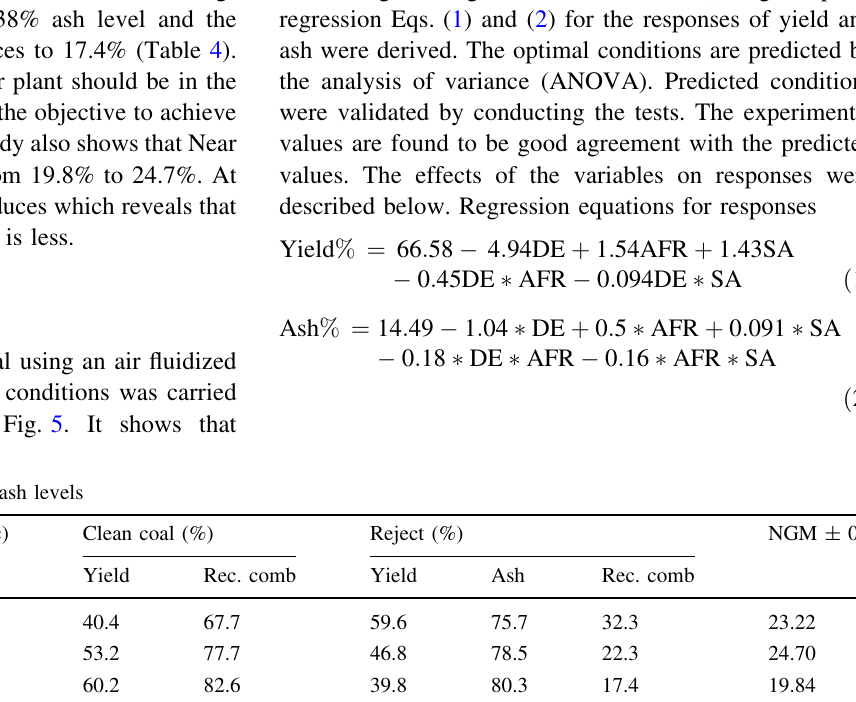
table using a Design Software version 8 (Design Expert), regression Eqs. (1) and (2) for the responses of yield and ash were derived. The optimal conditions are predicted by the analysis of variance (ANOVA). Predicted conditions were validated by conducting the tests. The experimental values are found to be good agreement with the predicted values. The effects of the variables on responses were described below. Regression equations for responses